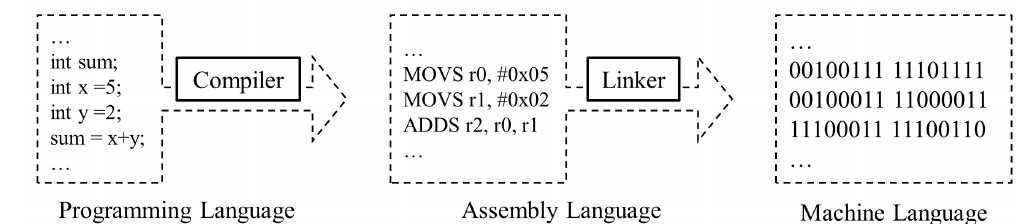
Figure 2. Flow of language transformation.